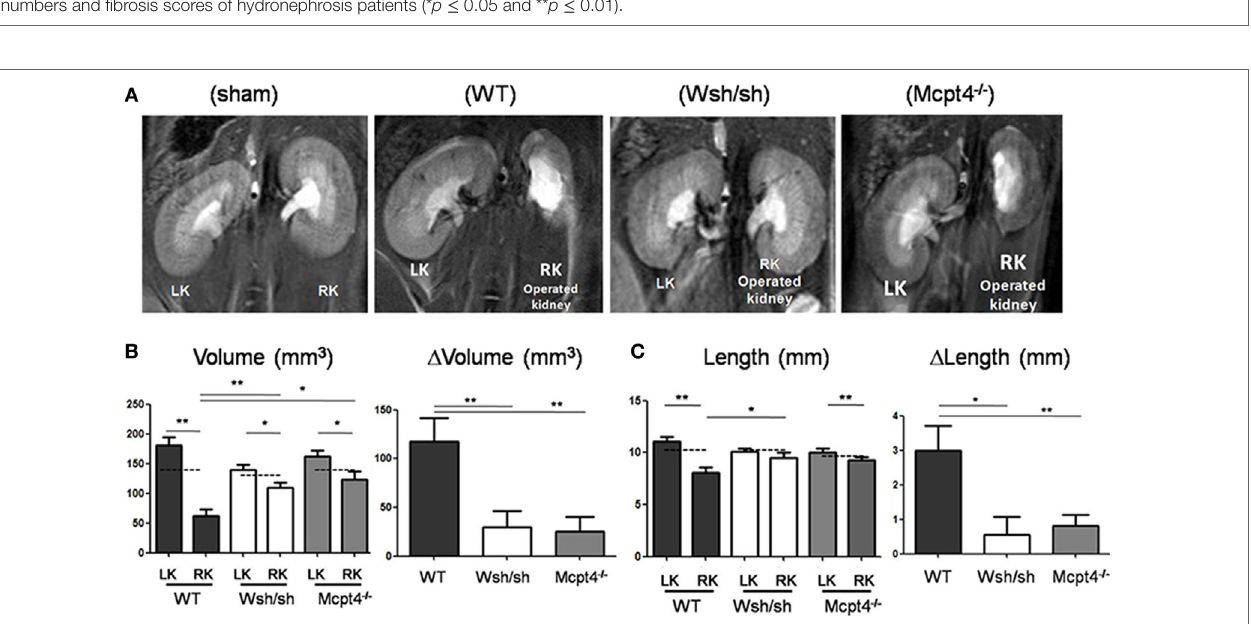
FigUre 2 | evaluation of renal pathology after partial unilateral ureteral obstruction (pUUO) by magnetic resonance imaging (Mri) . (a) Renal MRI using T2-weighted coronal sequences for wild-type (WT), mast cell (MC)-deficient and MCPT4-deficient mice at D75 after surgery. LK = non-operated left kidney and RK = operated right kidney with pUUO. Note the differences in morphology between hypotrophic right kidneys (RKs) and hypertrophic left kidneys (LKs). (B) Quantification of volume for RK and LK of the indicated mice at D75 post-surgery ( n = 8 for WT, 11 for MC, and 8 for MCPT4-deficient mice). The hatched line is the mean volume of control kidneys of from sham mice at D75. Delta volume ( Δ V) denotes the difference in volume between hypertrophic LK and hypotrophic RK for each strain of mice. Data are the mean ± SEM of indicated numbers of mice [see (a) ] (* p ≤ 0.05 and ** p ≤ 0.01). (c) Quantification of length data for RK and LK of indicated mice at D75 post-surgery ( n = 8 for WT, 9 for MC, and 12 for MCPT4-deficient mice). The hatched line is the length of control kidneys from sham mice at D75. Delta length ( Δ L) denotes the difference in length between hypertrophic LK and hypotrophic RK. Data are the mean ± SEM of indicated numbers of mice [see (a) ] (* p ≤ 0.05 and ** p ≤